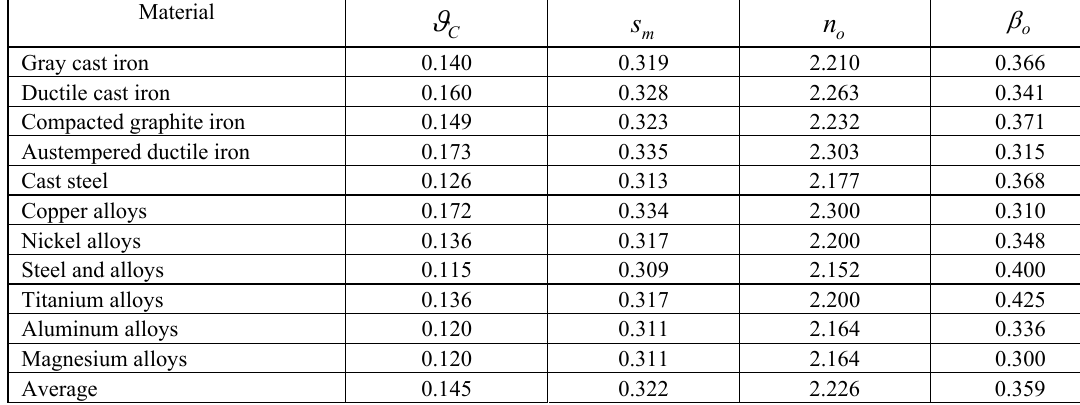
Table A3: Nominal Pulsating Strength Factor for common Gear Materials at 99% Reliability